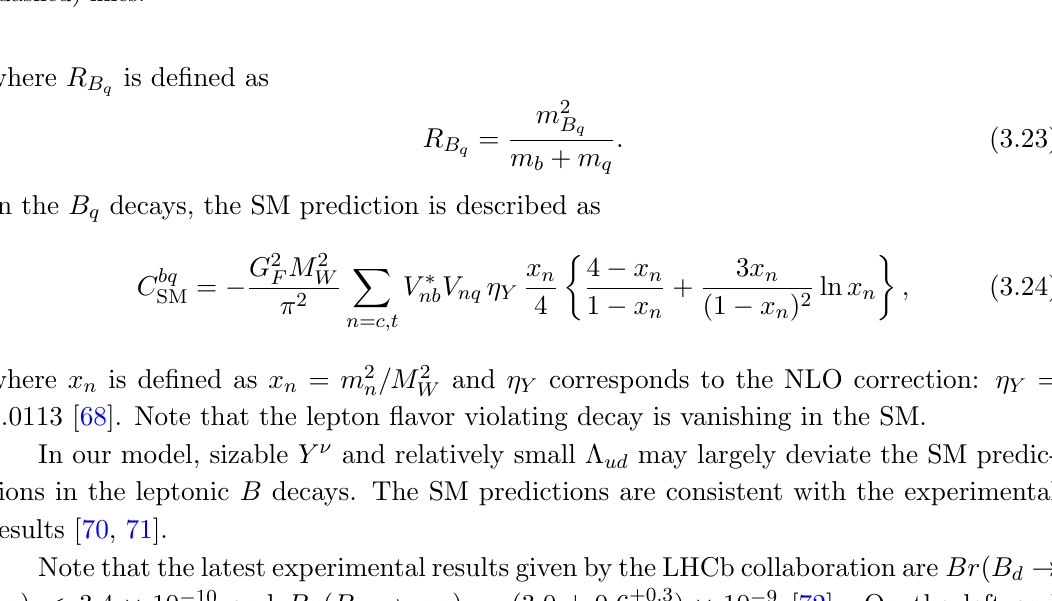
Figure 3 . Predictions of (cid:28) ! e(cid:22) + (cid:22) . The thick and dashed blue lines depict our predictions in the NO cases with ( Y (cid:23) ; Y (cid:23) ; M (cid:0) 1 ) = (1 ; 0 : 1 ; 0) on the left panel and ( Y (cid:23) 11 33 (cid:23) 1 on the right panel. The thick and dashed red line describes our predictions in the IO cases with ( Y (cid:23) ; Y (cid:23) ; M (cid:0) 1 ) = (1 ; 0 : 02 ; 0) on the left panel and ( Y (cid:23) 11 33 (cid:23) 1 panel, respectively. (cid:3) uu and (cid:3) ud are (cid:12)xed at ((cid:3) uu ; (cid:3) ud ) = (200 TeV ; 100 (6) TeV) on the thick (dashed)